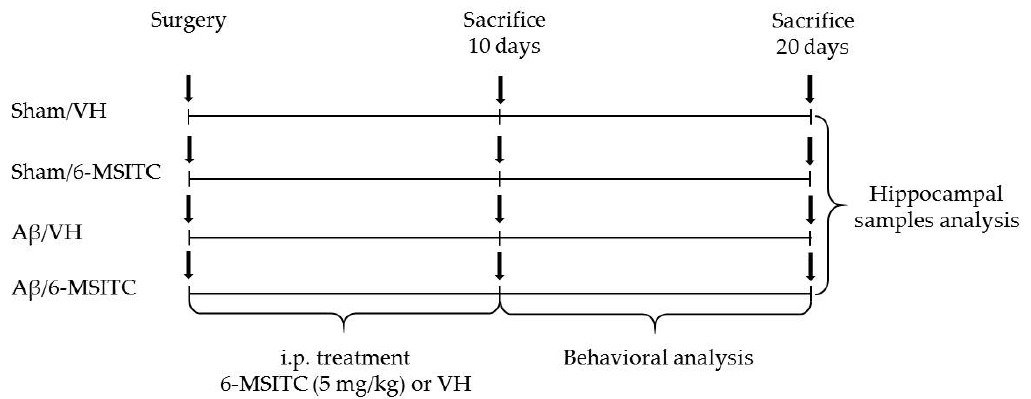
Figure 10. Experimental protocol and 6 ‐ MSITC treatment schedule. Mice received i.p. injection of 6 ‐ MSITC (5 mg/kg) for 10 days. Animals were sacrificed 10 or 20 days after A β 1–42 O injection.